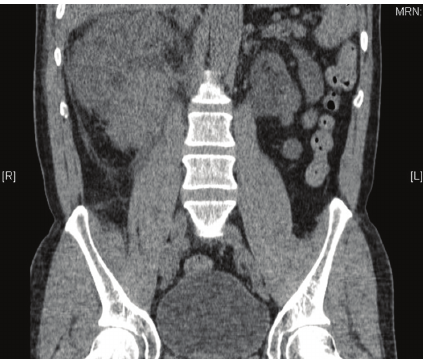
Figure 2: Coronal CT image demonstrating primary plasmacytoma of the kidney.